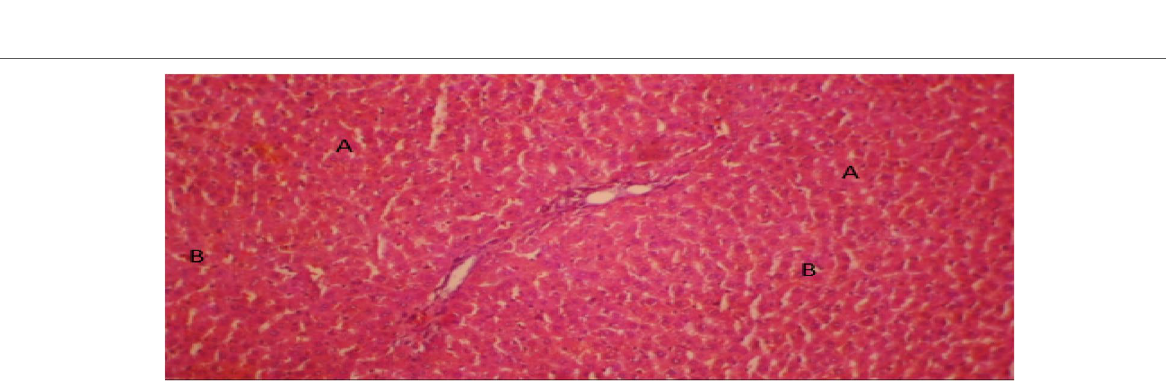
Fig. 9 Liver section of rat co-administered SA and 200mg/kg leaf extract for 14 days (Group 7) showing: A , normal hepatocytes and B , mild Kupffer cell activation (H&E x